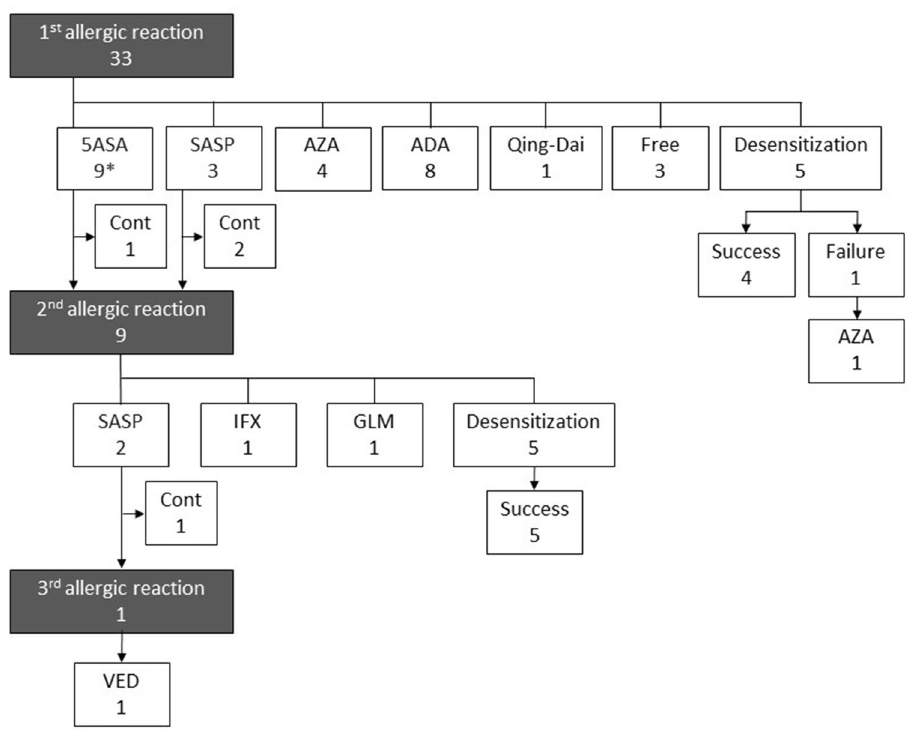
Figure 1. Flowchart of outcomes of mesalazine allergy patients. *Of nine patients who received other mesalazine formulations, three received multi-matrix mesalazine (4800 mg in all three patients), three received pH-dependent mesalazine (3600 mg in all three patients), and three patients received time-dependent mesalazine (4000 mg, 3000 mg, and 1000 mg). 5ASA 5-Aminosalicylic acid, SASP salazosulfapyridine, AZA azathioprine, ADA adalimumab, IFX infliximab, GLM golimumab, VED vedolizumab, Cont